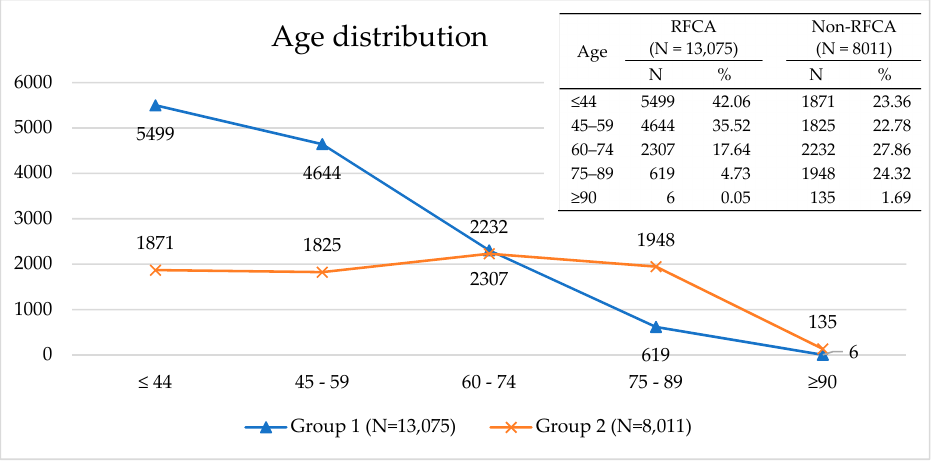
Figure 3. Age at 1st PSVT admission in two groups: group 1 included patients who underwent RFCA; Figure 3. Age at 1 st PSVT admission in two groups: group 1 included patients who underwent RFCA; group 2 included patients who did not. group 2 included patients who did